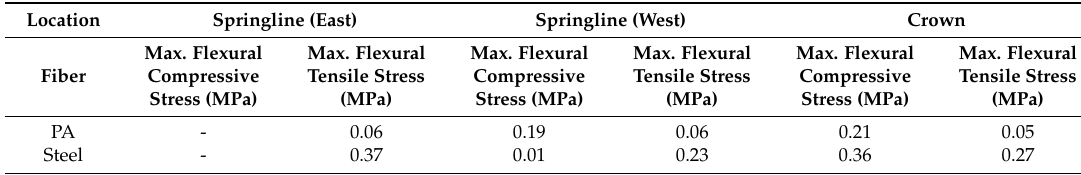
Table 9. Measured shotcrete stresses.